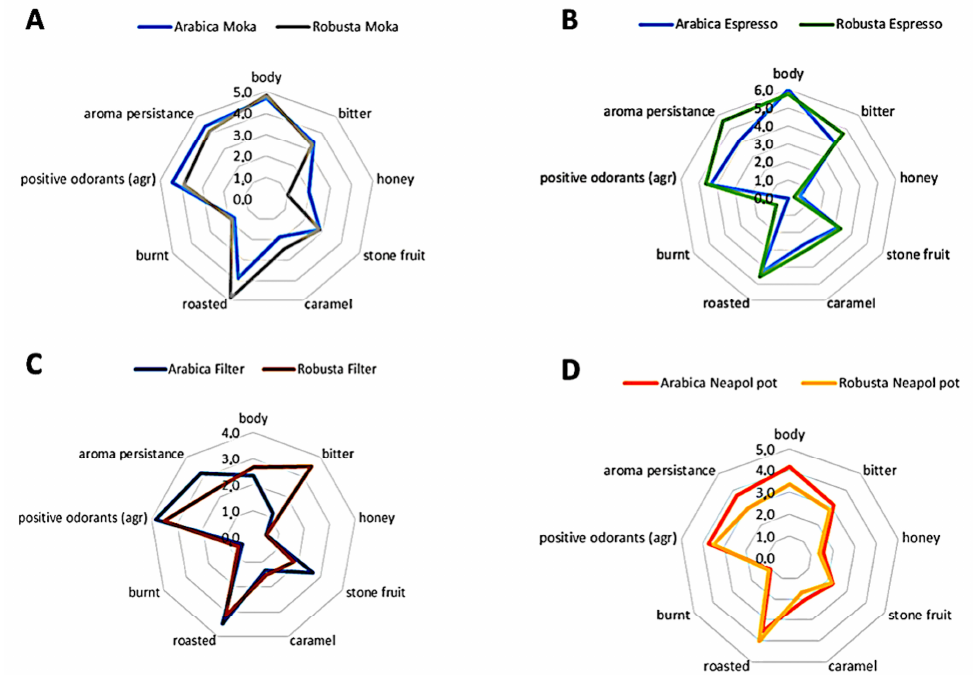
Figure 5. Sensory profiles of different coffee beverages corresponding to four extraction systems applied on Arabica and Robusta roasted coffee, and considering: Moka ( A ), Espresso ( B ), Filter ( C ), and Neapolitan ( D ) extraction